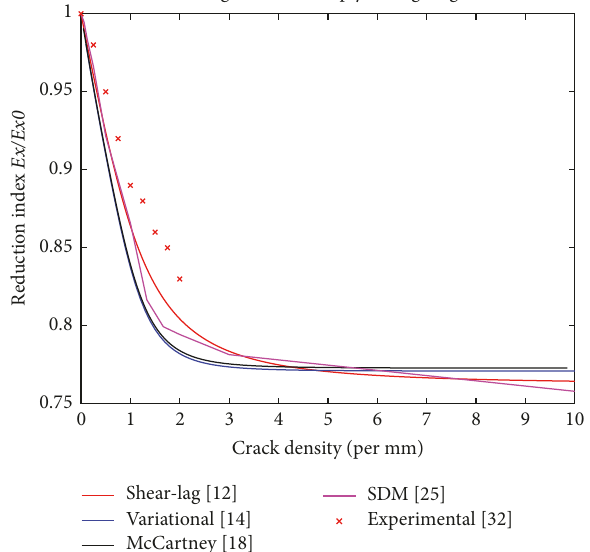
Figure 8: Curve comparing the four methods covered in this paper for longitudinal Young’s modulus reduction on a [0/90] s glass fiber/epoxy